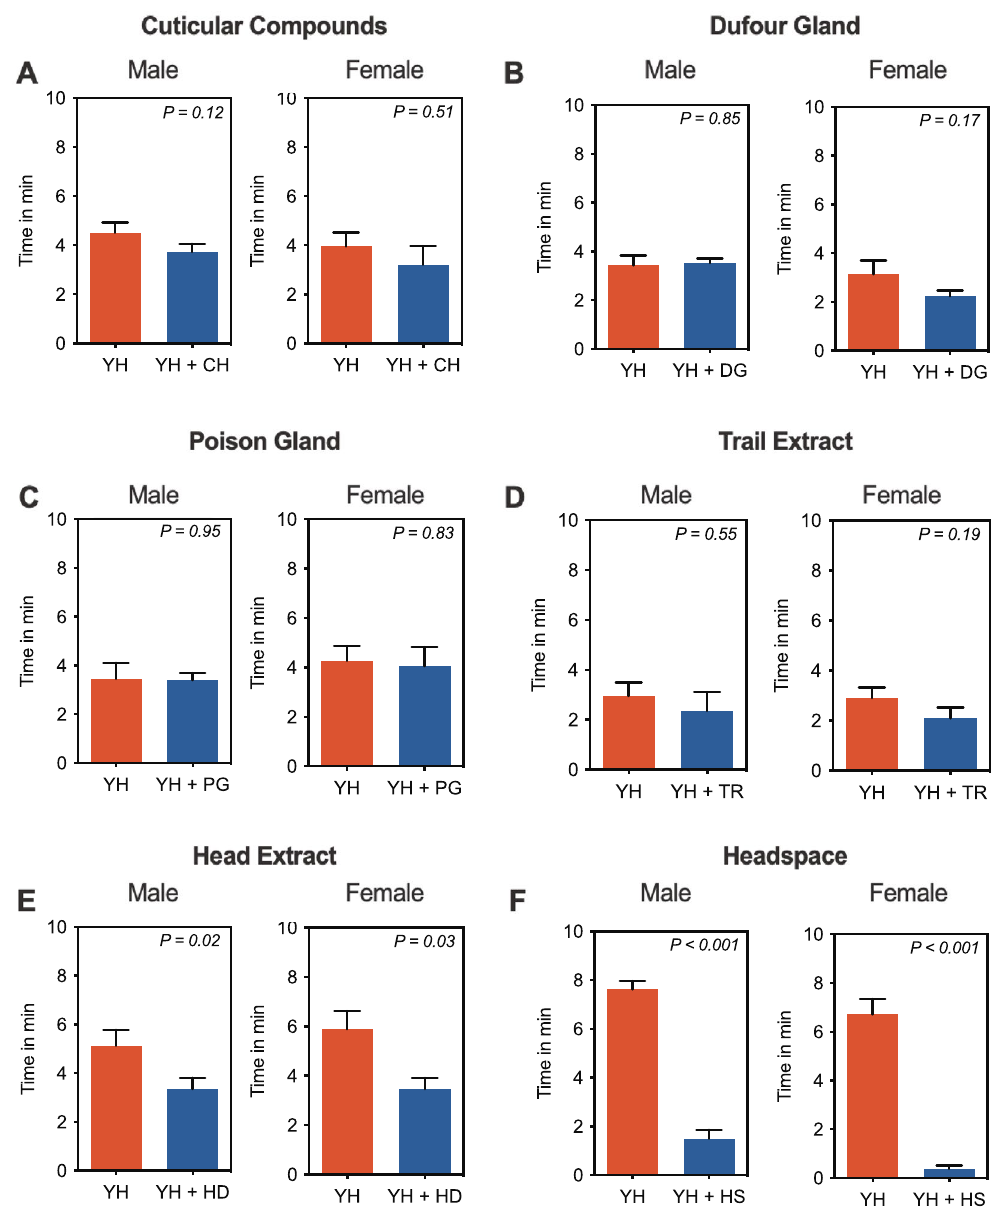
Figure 1. Behavioural response of male and female B. tryoni to O. smaragdina body extracts and volatiles. ( A ) cuticular compounds; CH, ( B ) Dufour gland; DG, ( C ) poison gland; PG, ( D ) trail extract; TR ( E ) head extract; HD and ( F ) headspace volatiles; HS were tested. Only head extract and headspace volatiles significantly repelled flies. Male and female flies spent significantly more time in control arm (Yeast Hydrolysate; YH) than the treatment arm (Yeast Hydrolysate + Head extract or Yeast Hydrolysate + Headspace voltiles). Error bar represent s.e.m. Significant difference was analysed by paired t -test (see